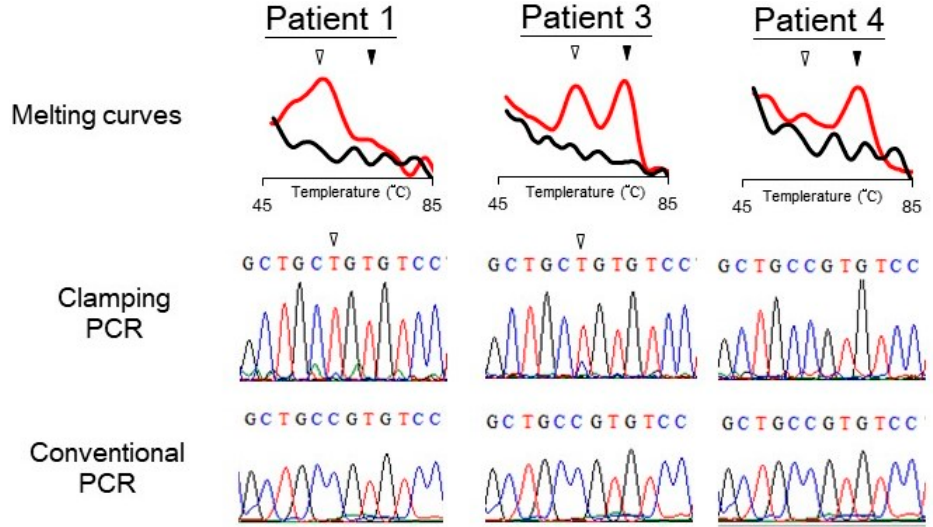
Figure 3. Typical results of detecting GNAS mutation in three patients with suspect McCune–Albright syndrome or fibrous dysplasia. The PNA probe assay generated melting curves of PCR products of the samples (top). The PCR products (marked as clamping PCR) were analyzed by Sanger sequencing (middle). For comparison, sequencing results from PCR products without using PNA probe (marked as conventional PCR) are also shown (bottom). Open arrowheads indicate the position of mutant bases or mutant peaks; filled arrowheads indicate the wild-type peaks. Table 1. Clinical characteristics of six patients with MAS or FD.